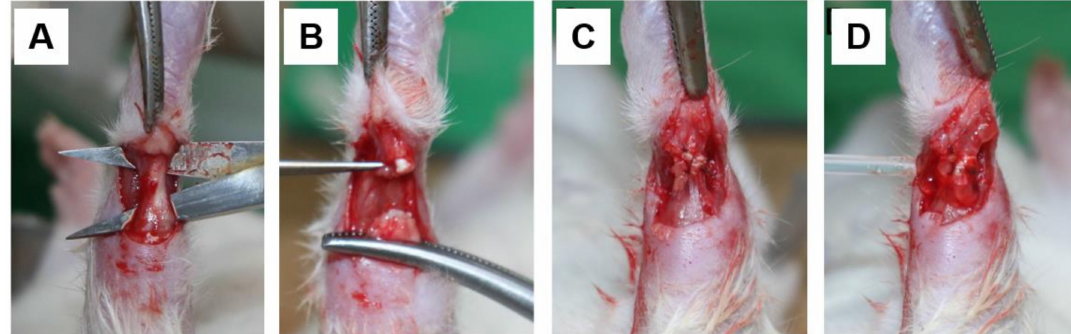
Figure 1. Graphical illustration. ( A ) The Achilles tendon is exposed. ( B ) A sharp incision is made with Metzenbaum scissors. ( C ) Primary tendon repair is performed following the modified Kessler method. ( D ) Hyaluronic acid (HyFence ® ; Ildong Pharmaceuticals, Seoul, Korea) is injected around the repaired tendon of the rats in the experimental group.